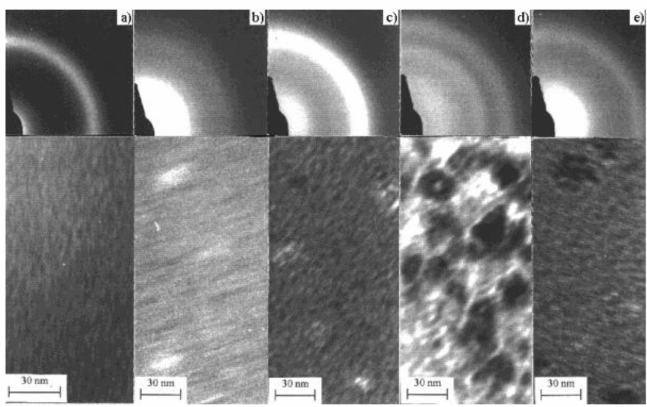
Figure 44. Illustration of the increasing degree of clusterization (micro-phase separation) in the amorphous state as observed during cyclic H saturation. ( a ) as-cast sample, ( b ) after first H absorption–desorption cycle, ( c ) after second H absorption–desorption cycle, ( d ) after third H absorption–desorption cycle, and ( e ) after fourth H absorption–desorption cycle. Enrichment of Cu is detected by SAD (Selected Area Electron Di ff raction). Adopted from [138], with permission from Elsevier, 1997.